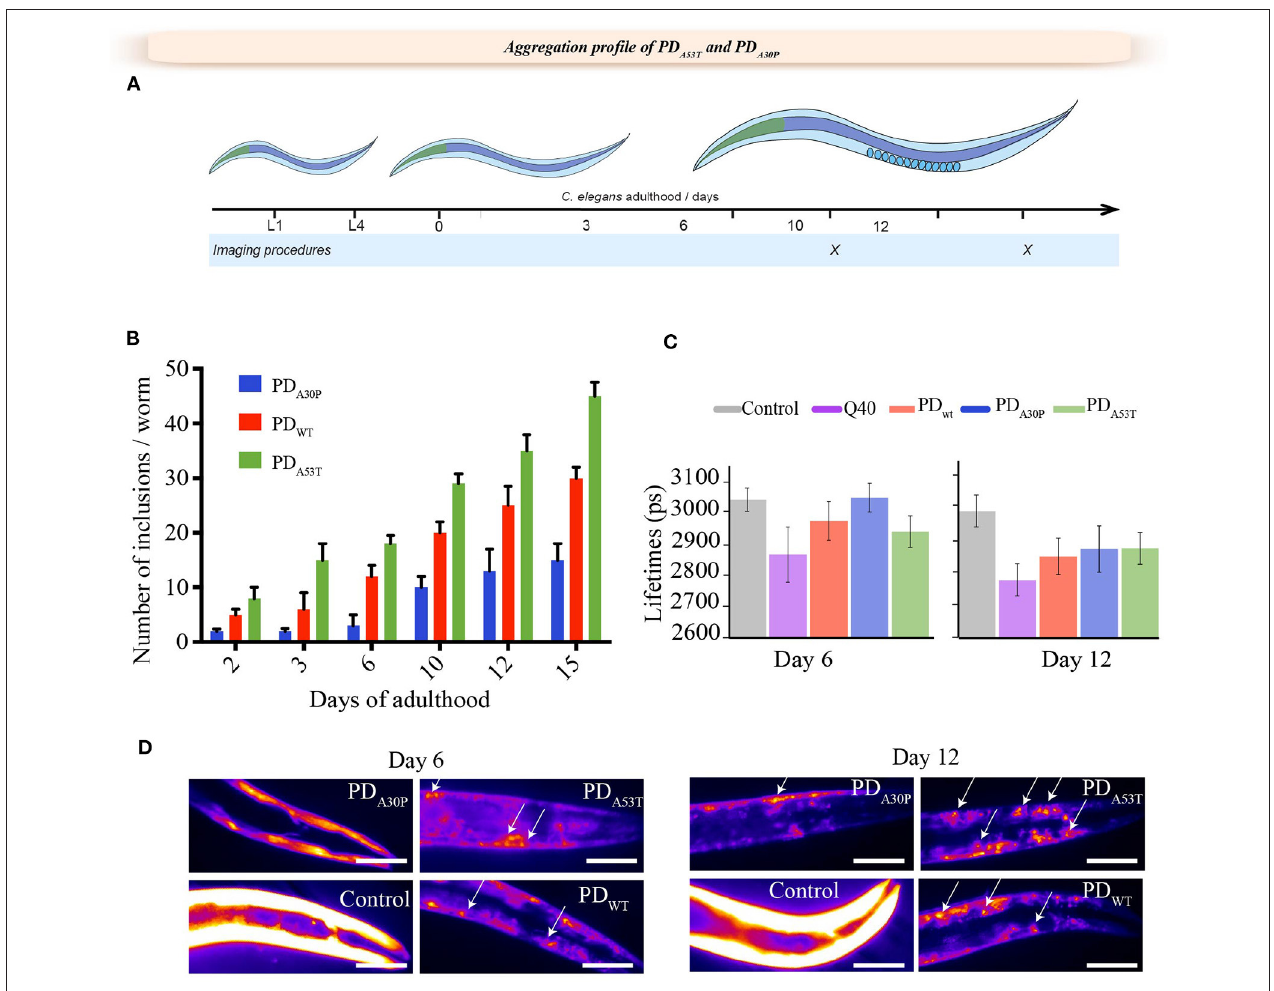
FIGURE 2 | Age-dependent formation of inclusions in PD A30P and PD A53T worms. (A) Schematic description of the lifespan of C. elegans . Days 6 and 12 of adulthood are reported here as representative for the formation of α -syn inclusions in vivo . (B) Quantification of the number of α -syn inclusions in PD A30P and PD A53T worms, compared to PD WT worms (Van Ham et al., 2008). (C) PD A30P and PD A53T amyloid-like aggregation profiles measured using TG-FLIM (Laine et al., 2019), (left) day 6 and (right) day 12. The average fluorescence lifetime (in ps) was measured for PD A30P (blue) and PD A53T (green) worms, and compared to control worms (gray) and PD WT worms (red) ( Van Ham et al., 2008), and to Q40 (pink) polyglutamine worms, which have a high propensity to form amyloid-like aggregates (Morley et al., 2002). The FLIM analysis shows no amyloid-like features in the α -syn inclusions in PD A30P worms at day 6 of adulthood, unlike PD A53T, PD WT and Q40 worms. A statistically significant increase in amyloid-like aggregation was observed in all the strains after day 12 of adulthood (insets) ( p < 0.05). For each experiment, 25 worms were analyzed. (D) Representative images showing the inclusion profile in PD A30P and PD A53T worms and compared to PD WT worms and YFP controls at day 6 and 12 (Van Ham et al.,